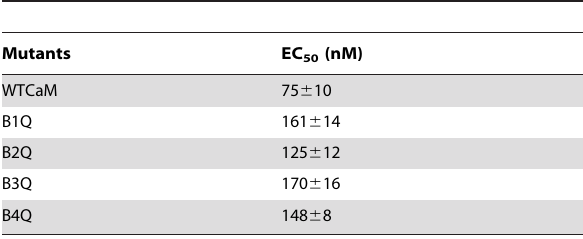
Table 2. The EC 50 for each CaM construct in activation of eNOS citrulline